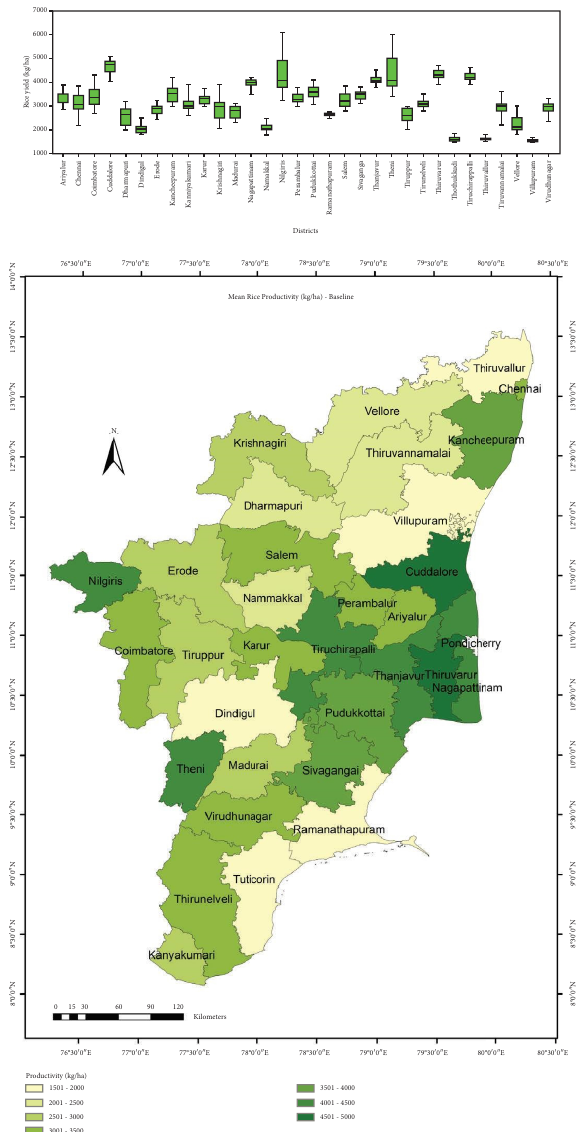
Figure 5: Current climate variability on rice productivity over Tamil Nadu (baseline